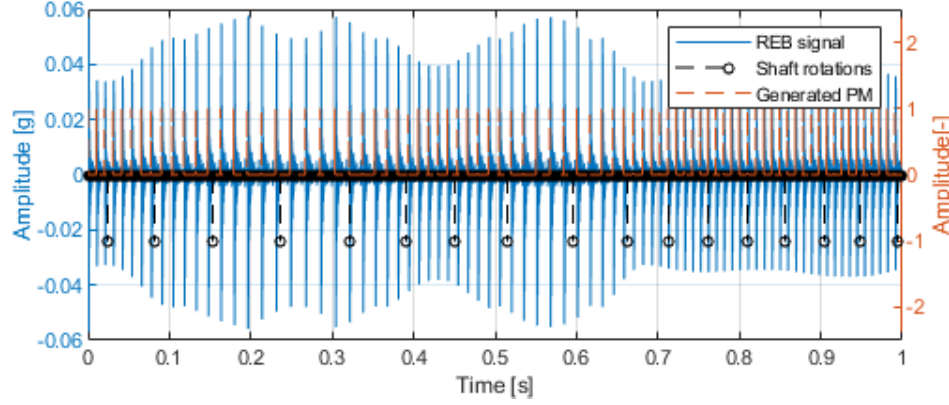
Figure 18. PM signal reconstructed from shaft component.